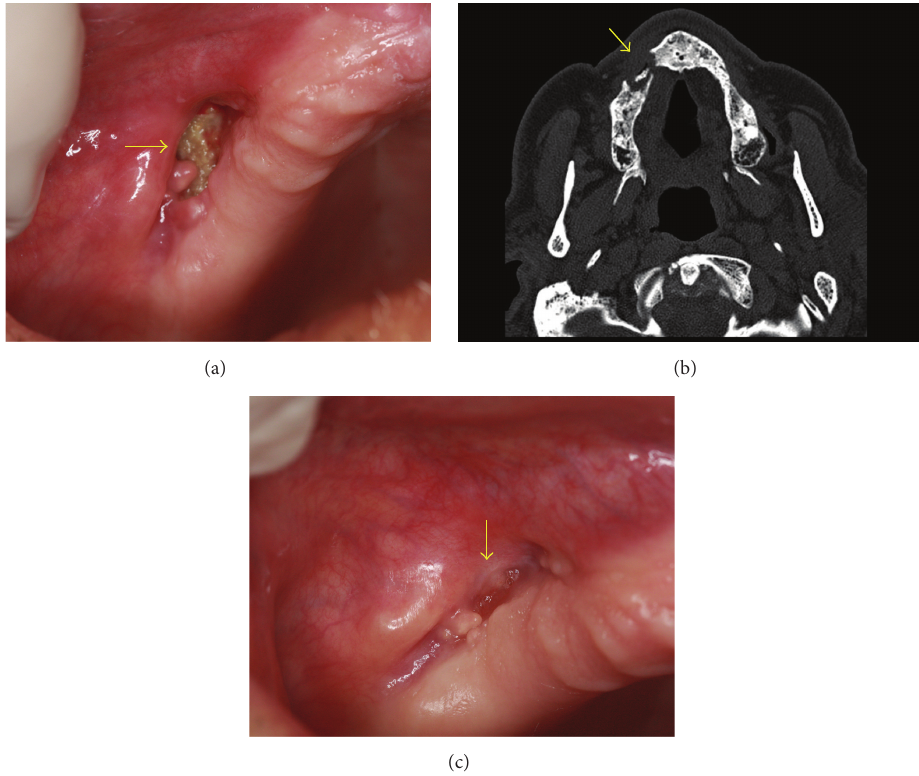
Figure 1: Clinical aspect of bone exposure measuring approximately 1.5 cm at vestibular sulcus of right maxilla (a). CT showing bone lysis and necrotic bone sequestrum at maxilla with oral antral communication risk (b). Clinical aspect of vestibular sulcus mucosa totally recovered after 37 sessions of LLLT and PDT